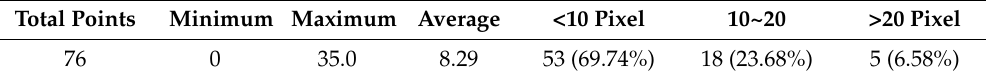
Table 1. Checking epipolar bias in a panoramic image with known correspondent points.